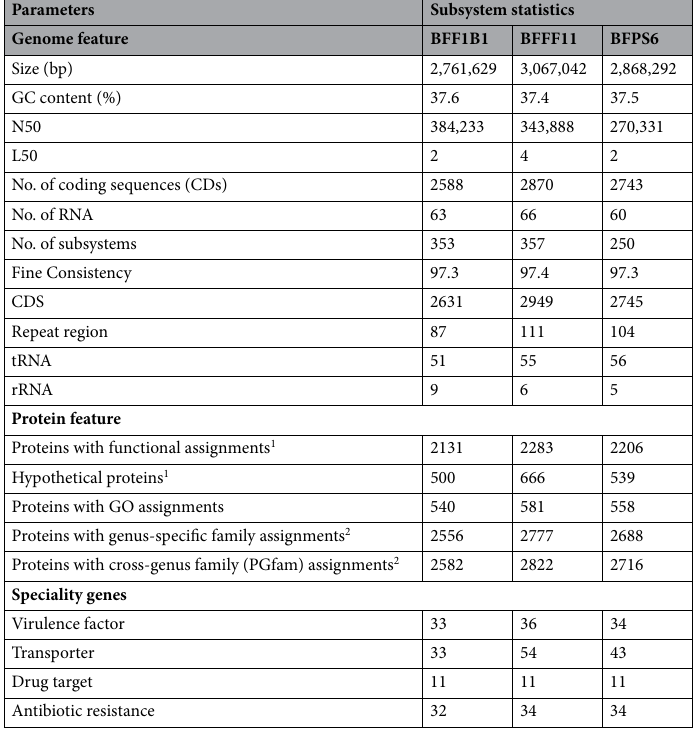
factors; two aggregation substance encoding genes agg and prgB were absent in the genomes of BFF1B1and BFPS6. Numbers of virulence genes for DNA and protein synthesis were found in the genome sequences of all three strains, namely DNA repair enzymes synthesis gene ( recQ1 and phrB ), purine metabolism gene ( purl ), thymidylate synthase ( thyA ), methionine aminopeptidase ( map ) and sucrose operon repressors genes ( scrB-1 and scrR-1 ). Among three strains, BFF1B1 and BFFF11 harbor ctrA gene that functions as a negative regulator of DNA replication. Other virulence factors included sex pheromone associated genes ( cad, cCF10, camE , cOB1 ), the cell wall adhesion expressed in serum gene ( efaA ), the enterococcal Rgg-like regulator gene, amino acid transport and synthesis regulators ( brnQ ), and gene associated with macrophage persistence ( ElrA ). Cytolysin toxin-producing genes cylR2 and cylI was identified in BFF1B1 by VFDB and BFPS6 by PATRIC, however, these were not identified in the BFFF11 strain. Furthermore, 11 capsule producing genes ( cpsA to cpsK ) associated with anti-phagocytosis were identified in the strain BFFF11; among those only 3 genes ( cpsA , cpsB and cpsF ) were in the Thai sarpunti originated BFPS6 and only cpsA was found in the BFF1B1. Heat shock regulation protease gene ( clpP ), transla- tion elongation factor ( tufA ) and UDP-galactopyranose mutase synthesis gene ( glf ) which play important roles in cell surface formation and infection cycle of pathogens were found only in the strain BFF1B1. A relatively large number of virulence genes were identified using the VFDB database, and the lowest was identified using the virulence finder (Fig. 3b). Antibiotic‑resistance gene. A total of thirty-nine antibiotic-resistance genes belonging to sixteen dif- ferent groups were identified among the strains of E. faecalis (Table 2). Except for four genes including tet(M), tet(L), tet(S) and tet(45 ), all of the genes were conserved by the genome sequences of all three strains of E. fae- calis. Although tetracyclines, aminoglycosides, phenicol antibiotics resistant gene YkkCD and tetracyclines, gly- cylcyclines resistant gene S10p were conserved in all the genome sequences of present study strains, four genes such as tet(M), tet(L), tet(S) and tet(45 ) conferring resistance to tetracycline were identified only in the genome sequence of BFPS6 with 77.14–100% of identity. fied, found to be resistant against MLS and rifamycin antibiotics. Eight antibiotic-resistance genes included LiaR, LiaS, LiaF, MprF, GdpD , PgsA, rpoB and rpoC were found where seven of them were resistant against daptomycin